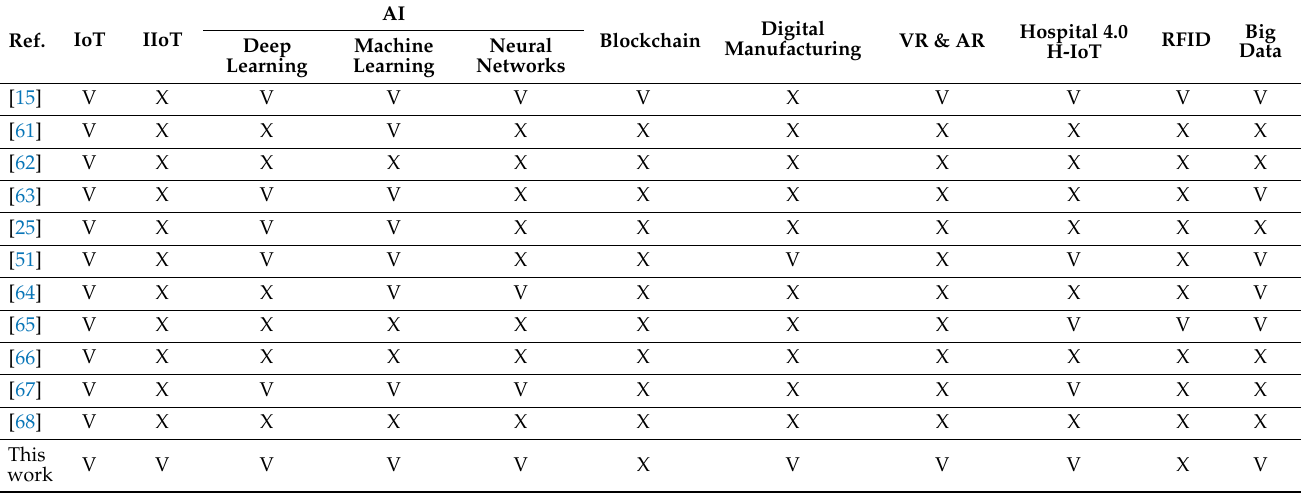
Table 2. The key technologies discussed in the recent review publications (adapted and expanded from [15]). Here, “V” stands for the presence, and “X” for the absence of discussion on the relevant topics that make up an Industrial 4.0